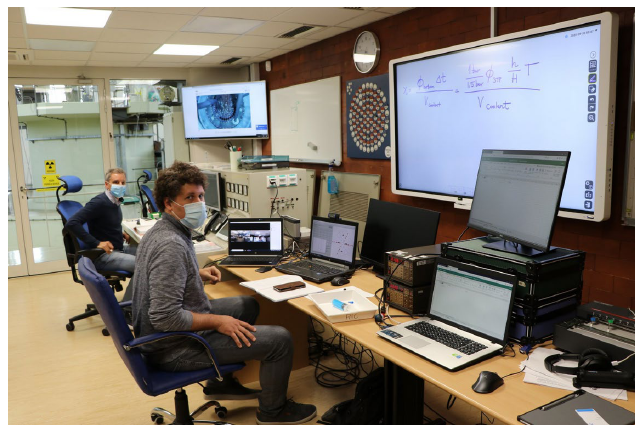
Fig. 12. Reactor operator and demonstrator in the JSI TRIGA control room conductin an remote experiment - September 28 th -October 2 nd , 2020.